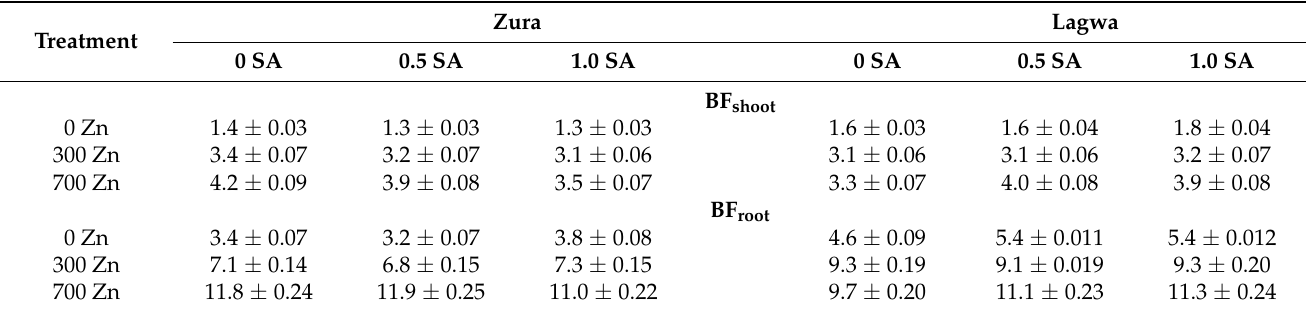
Table 3. Bioaccumulation factors of Zn ( ± SE).